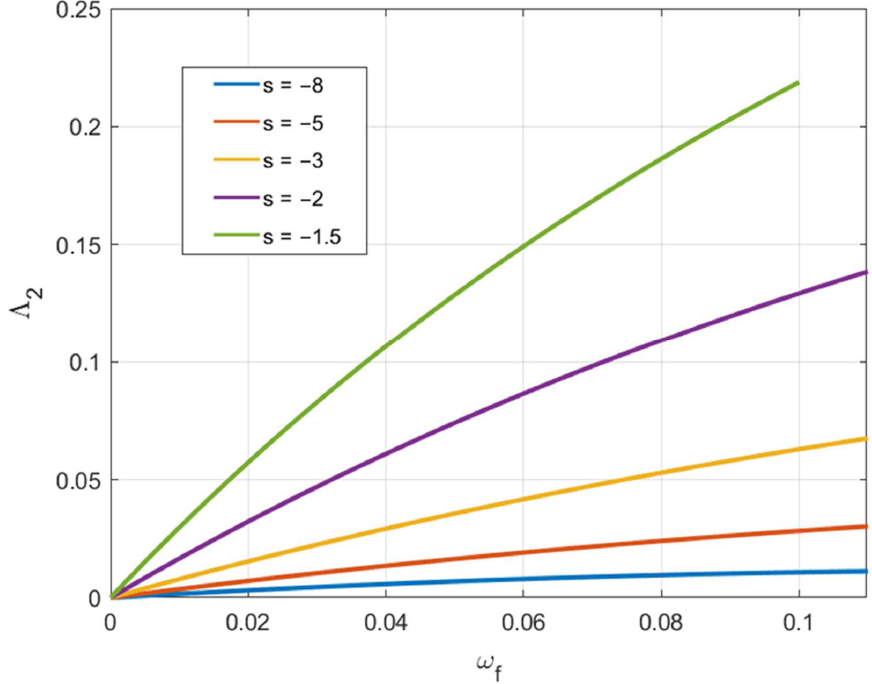
L Figure 11. Variation of Λ 2 involved in Equation (57) with the axial feeding for several loading Figure 11. Variation of 2 involved in Equation (57) with the axial feeding for several loading paths.